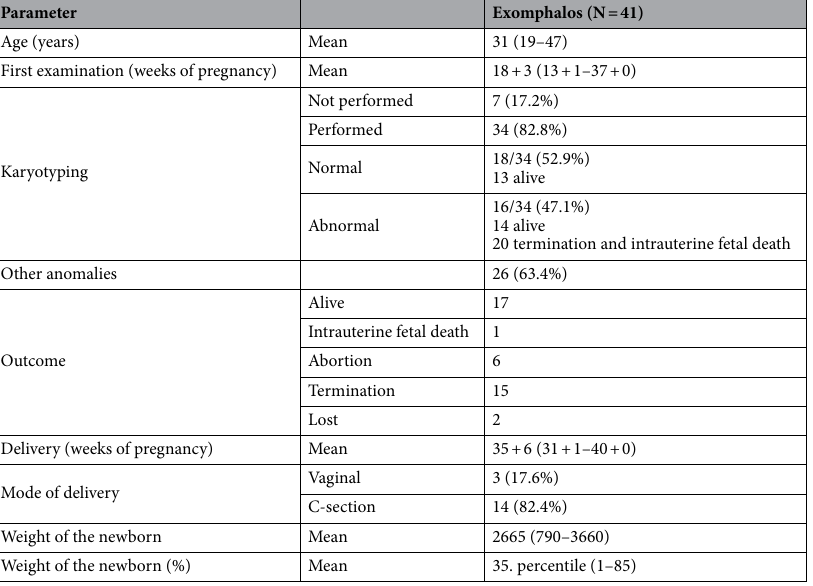
Table 1. Maternal characteristics and outcome of cases with